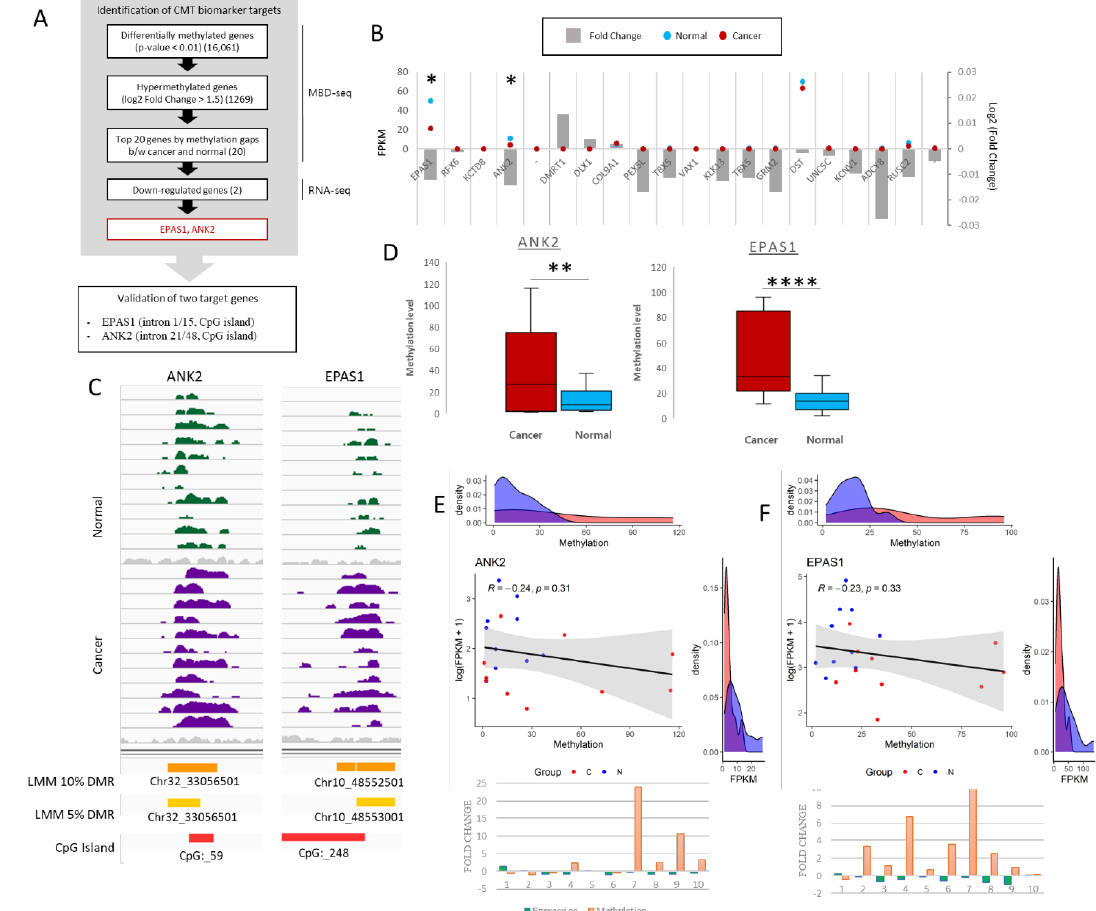
Figure 1. Selection of ANK2 and EPAS1 as canine mammary tumor (CMT) hypermethylated targets. ( A ) Schematic overview of target selection using MBD-seq and RNA-seq. Each step indicates the number of identified genes at the end of that step. ( B ) RNA-seq gene expression in FPKM of top 20 hypermethylated genes; blue dots = normal, red dots = CMT, * = p -value < 0.05. Fold change (log2) for each target gene indicated with grey bar graph. ( C ) IGV peak calling for ANK2 and EPAS1 in both normal and cancer. Differential methylation assigned via LMM with both 5% and 10% threshold, and CpG island presence is indicated. ( D ) Overall methylation levels of ANK2 and EPAS1 from MBD-seq data for 11 paired CMT and adjacent normal samples. EdgeR. ** = p -value < 0.01, **** = p -value < 0.0001. ( E ) ANK2 and ( F ) EPAS1 correlation plots between expression (FPKM) and methylation of 10 paired CMT (red) and normal (blue) samples with matching density plots for both FPKM and methylation. Pearson correlation |r| value and p value indicated. Fold change graphs are also depicted for 10 CMT samples indicating expression (green) and methylation (orange).